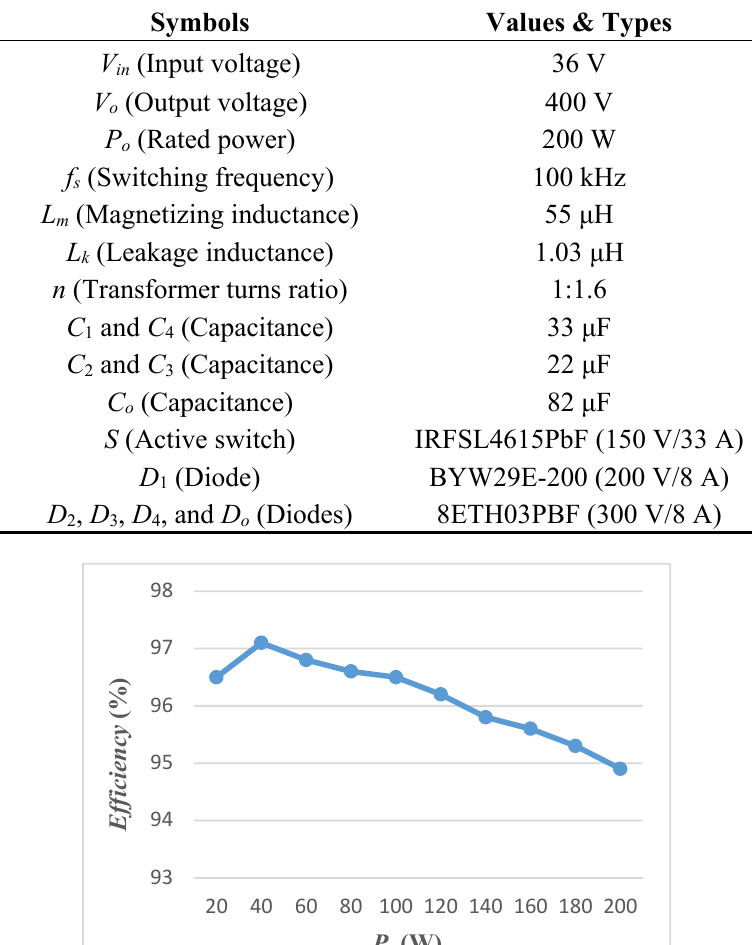
Table 2. Specifications of the prototype.